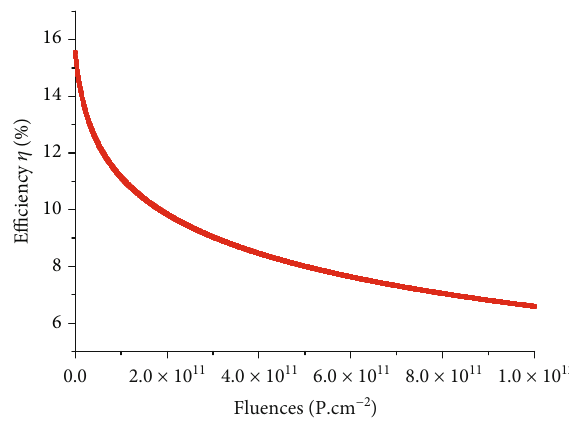
= 0 : 02cm ; Sb = 4 : 10 4 cm : s − 1 ; 0